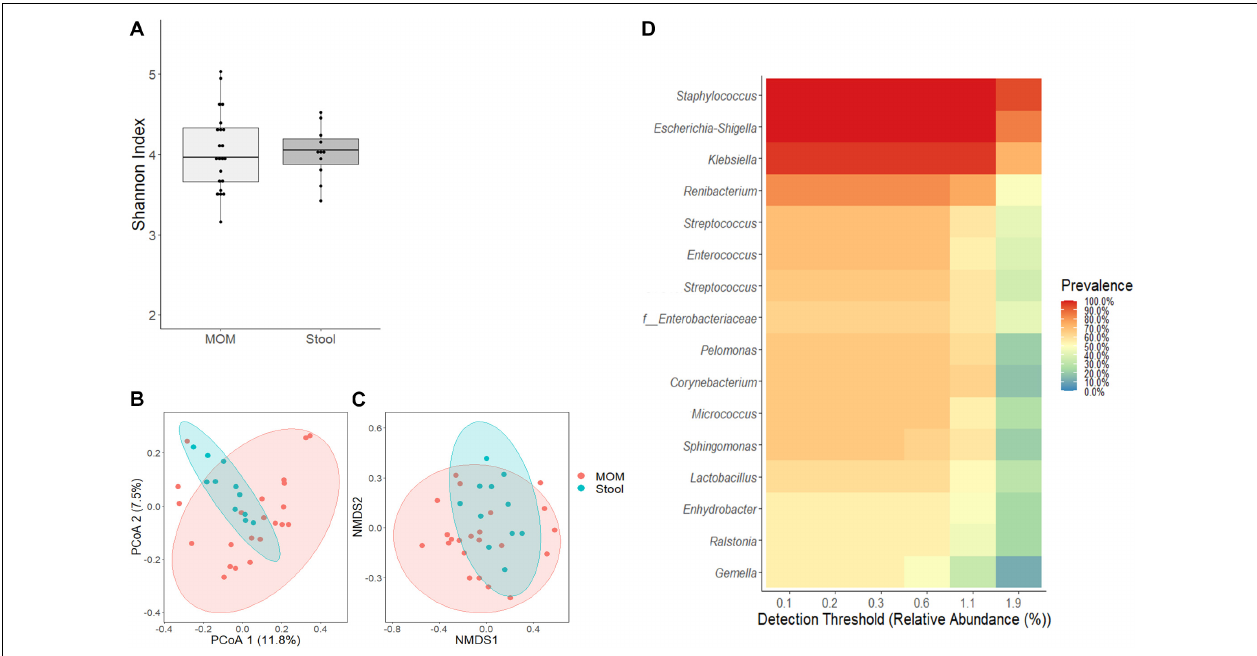
FIGURE 3 | Comparative analyses of MOM (light gray box) and stool (gray box) microbiome. (A) Alpha diversity determined using Shannon index; statistical significance was determined using Kruskal–Wallis tests. (B) PCoA and (C) NMDS analysis of stool and MOM samples. PERMANOVA was used to analyze statistical significance regarding the distance between the samples. (D) Determination of core-taxa shared by stool and MOM samples. A minimum detection of 0.001 and a prevalence = 50/100 were used to define the core-taxa.